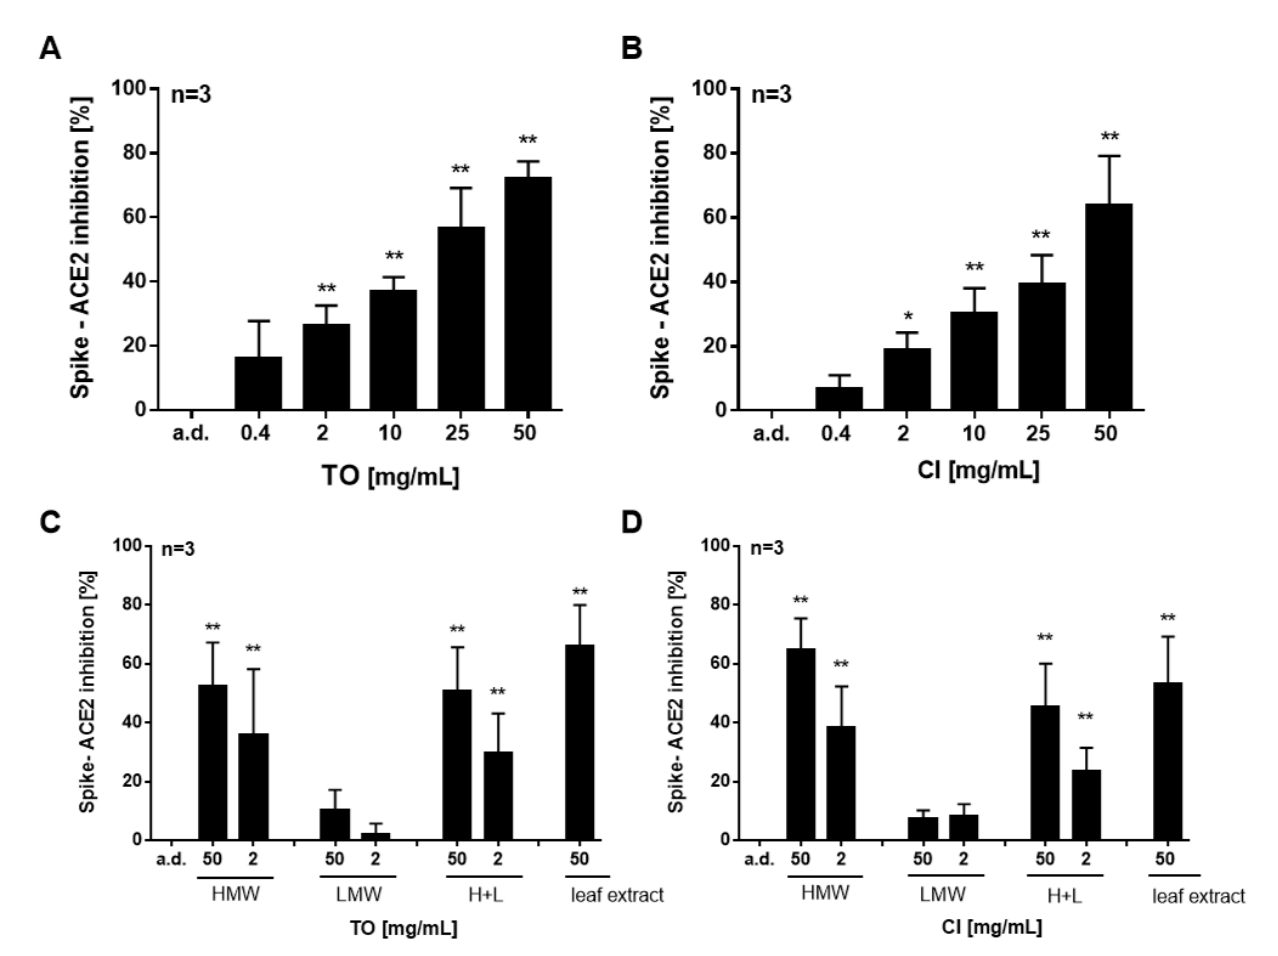
Figure 2. Effect of T. officinale and C. intybus extracts on SARS-CoV-2-Spike–ACE 2 inhibition. ( A , B ) Concentration- dependent effect of T. officinale (TO) and C. intybus (CI) extract. ( C , D ). Effect of fractions from TO and CI leaf extract. The extracts were freeze-dried and a molecular weight fractionation was subsequently carried out. The cut-off was set to 5 kDa (HMW > 5 kDa, LMW < 5kDa). H+L: HMW and LMW fractions; 50 mg of dried leaves per mL water was used as reference. HMW and LMW fraction quantities equivalent to dried leaves were used. The binding inhibition was assessed using ELISA technique. Bars are means + SD. Solvent control: distilled water (a.d.); * p < 0.05, ** p < 0.01. Significance of difference was calculated relative to the solvent control by one-way ANOVA.